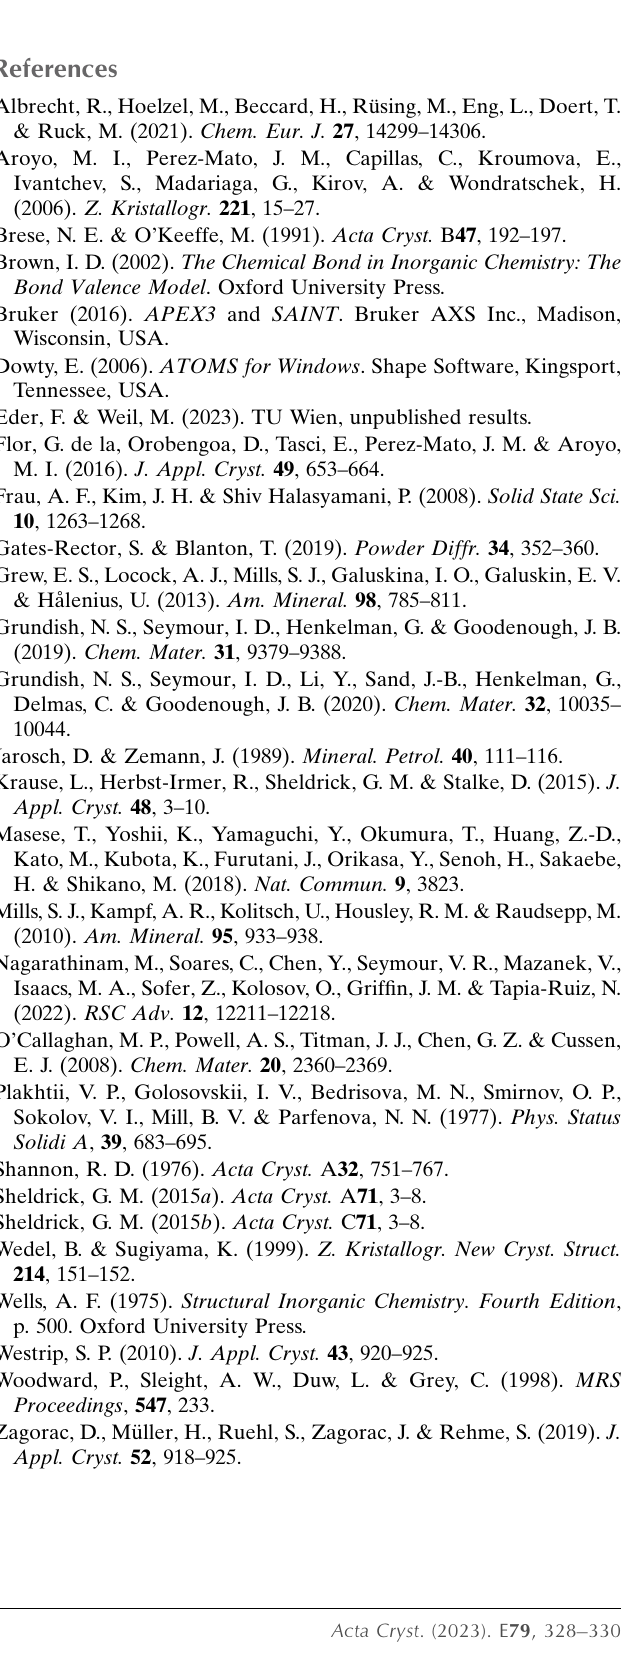
Table 2 Experimental details. Crystal data Chemical